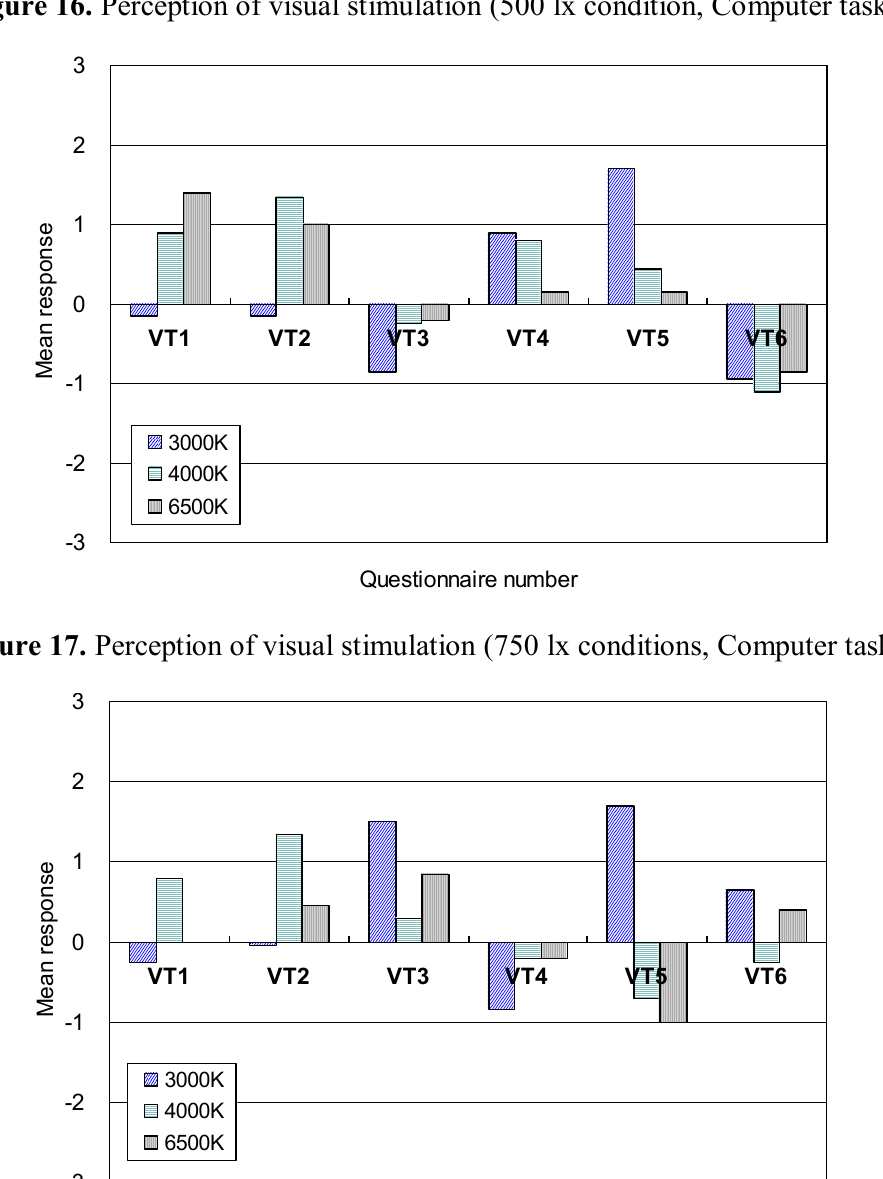
Figure 16. Perception of visual stimulation (500 lx condition, Computer task).